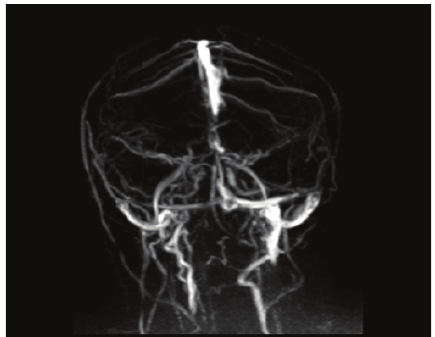
Figure 1: Left lateral sinus thrombosis on magnetic resonance.